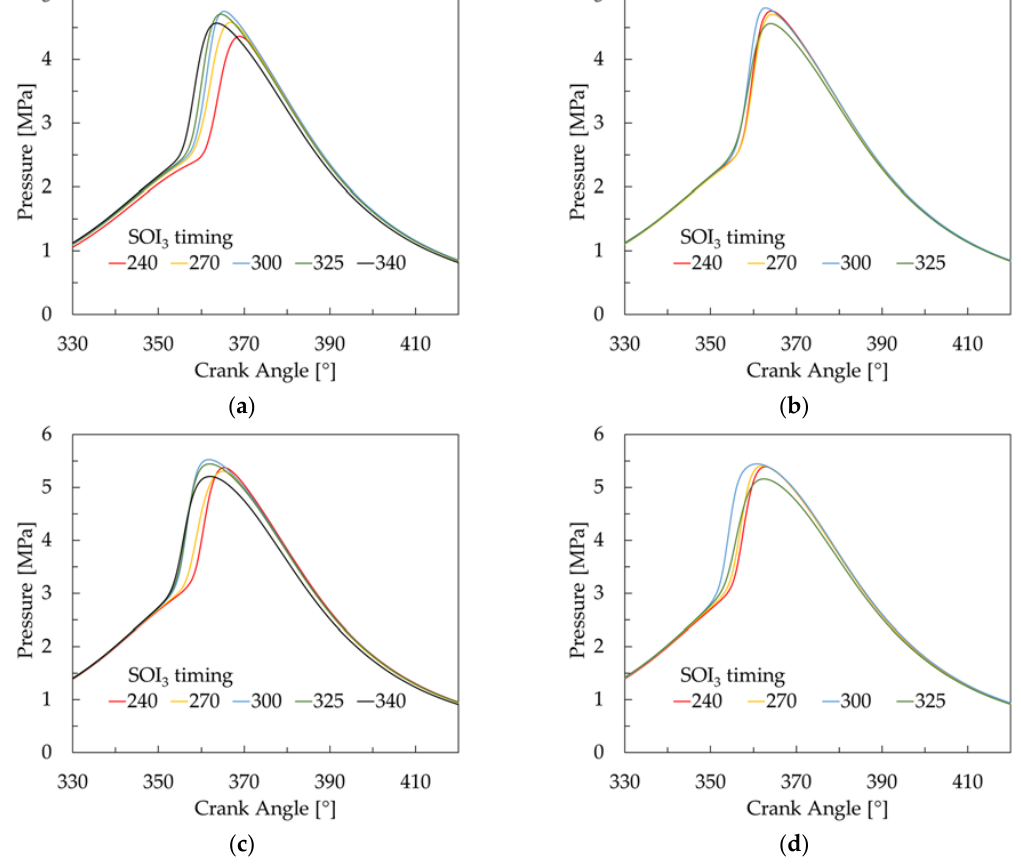
Figure 3. In ‐ cylinder pressure: ( a ) λ = 1.3, m F3 = 2.4 mg; ( b ) λ = 1.3, m F3 = 5.2 mg; ( c ) λ = 1.6, m F3 = 2.4 mg; ( d ) λ = 1.6, m F3 = 5.2 mg.